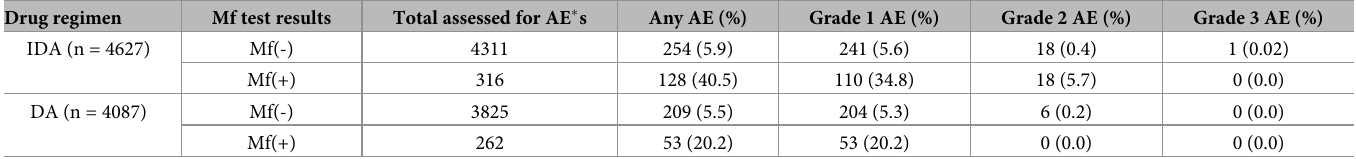
Table 5. Adverse events by microfilaremia (Mf) and treatment regimen. No AE’s beyond Grade 3 were observed. Drug regimen